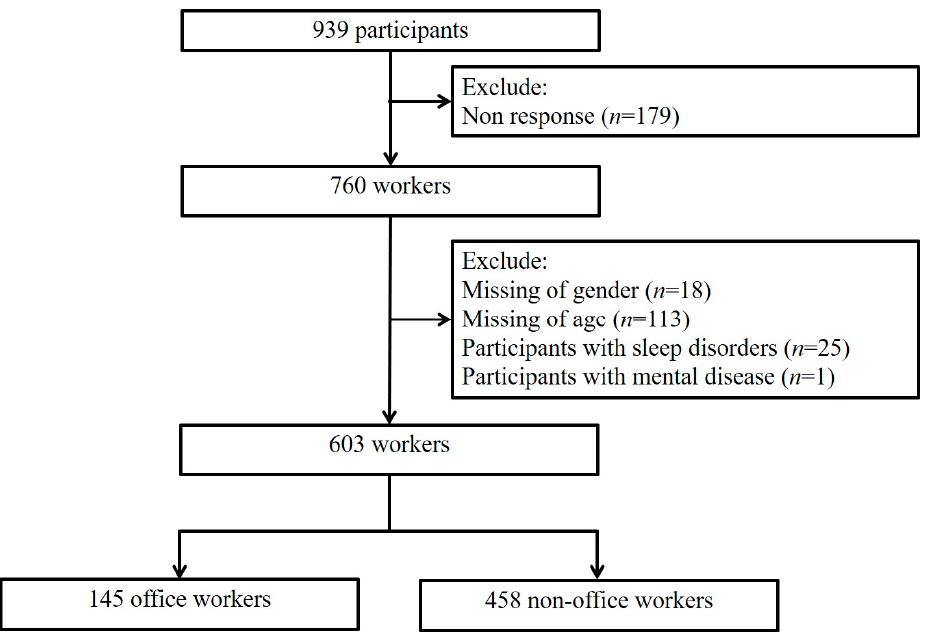
Figure 1. Flow chart of recruiting study population.